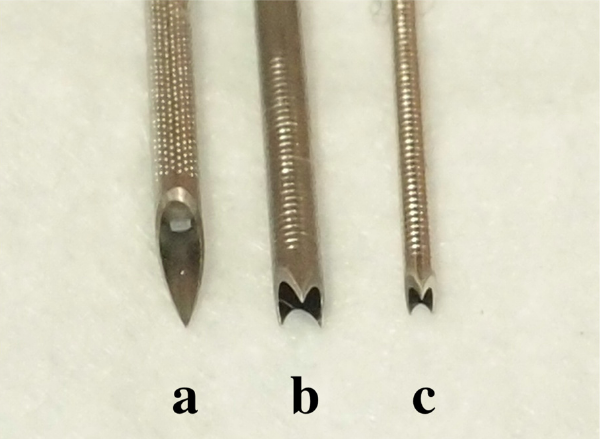
Figure 1. FNB and FNA needles ( a ) 19-gauge EZshot3 ® . ( b ) 19-gauge Acquire ® . ( c ) 22-gauge